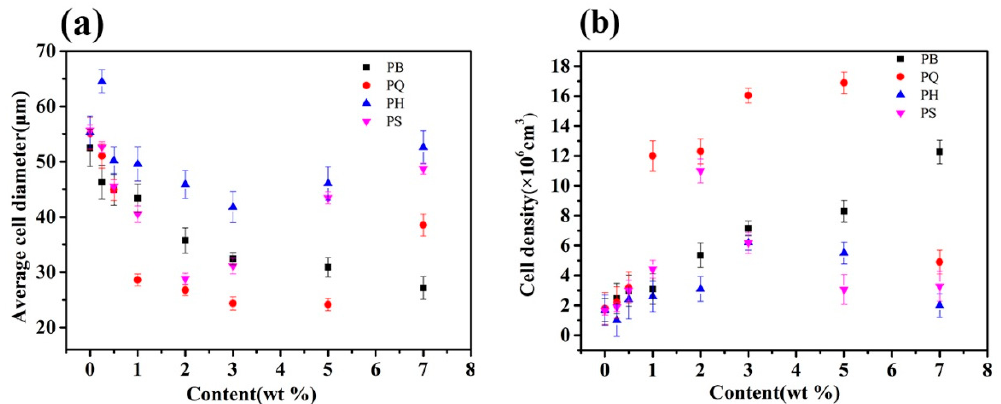
Figure 9. The average cell diameters ( a ) and cell densities ( b ) of the foamed PP composites with different contents.